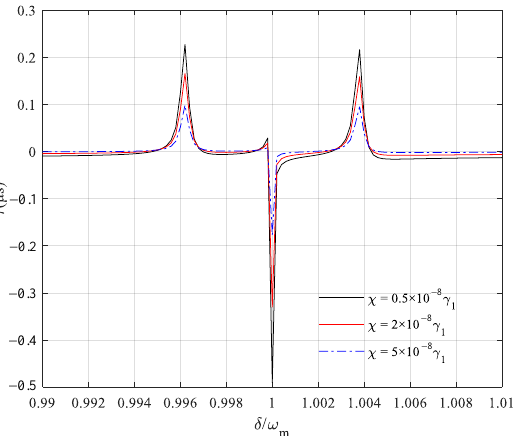
 for different values of the Figure 5. Group delay τ as a function of the probe detuning δ / ω m for different values of the Figure 5. Group delay  as a function of the probe detuning m Kerr coefficient χ . χ = 5 × 10 − 9 γ 1 (black, solid curve); χ = 2 × 10 − 8 γ 1 (red, dashed curve); 5 10   − =  (black, solid curve); 8 2 10   − =  (red, dashed curve); Kerr coefficient  . 9 1 1 χ = 5 × 10 − 8 γ 1 (blue, dash-dotted curve). g 1 = 2 × 10 − 5 γ 1 , and the other parameter values are the 8 2 10 g  − =  , and the other parameter values are the 5 10   − =  (blue, dash-dotted curve). 5 1 1 1 same as in Figure same as in Figure 3.